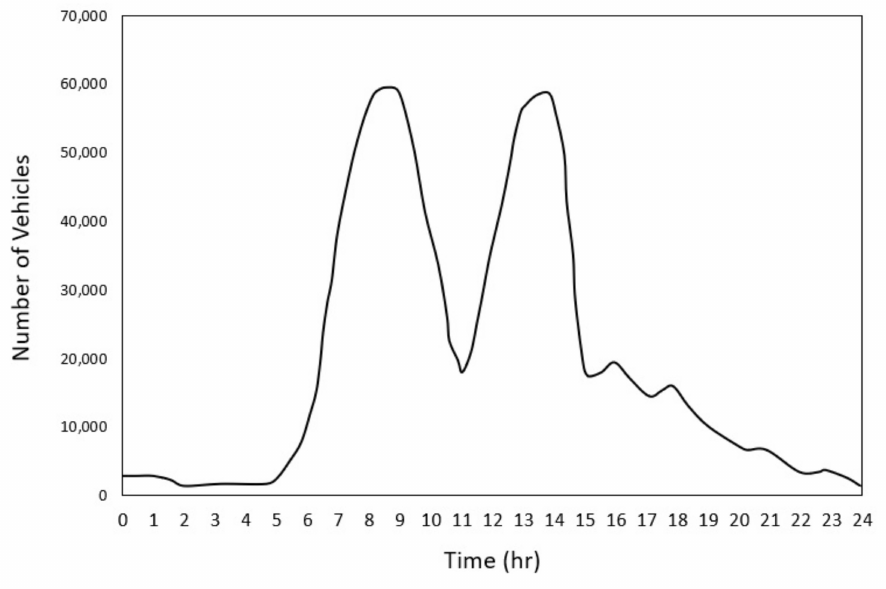
Figure 5. Number of vehicles in the network over time for the 462,720-vehicle